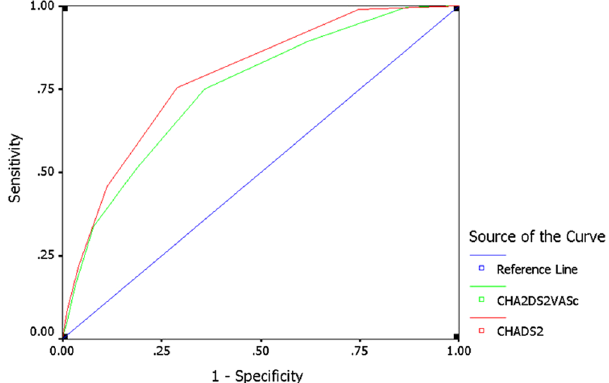
Figure 1. Receiver operating characteristic curves (ROC) for CHADS 2 and CHA 2 DS 2 -VASc scores for prediction of acute myocardial infarction (AMI) in patients with atrial fibrillation (AF). The area under the receiver operating characteristic curve (AUC) for CHADS 2 score predicting AMI is 0.787 (0.763–0.812), P < 0.001. The sensitivity and specificity for a CHADS 2 score ≥ 2 are 75.3% and 71.1%, respectively. The AUC for CHA 2 DS 2 -VASc score is 0.750 (0.722–0.777), P < 0.001. The sensitivity and specificity for a CHA 2 DS 2 - VASc score ≥ 3 are 75.0% and 64.1%, respectively. The difference between the two areas under the curves is not significant ( P >